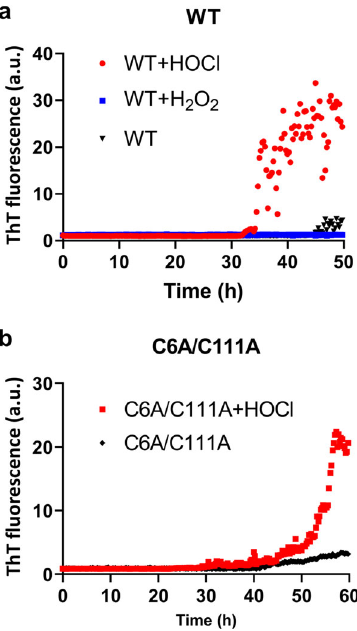
Fig. 6 Promotion of SOD1 fi lament formation by HOCl. The ThT fl uorescence intensities represent the fi lament formation of the wild-type SOD1 protein ( a ) or the C6A/C111A mutant SOD1 protein ( b ). Each protein was treated with HOCl (red), H 2 O 2 (blue), or none (black). The data points are shown as the mean of three independent experiments. The individual raw datasets are presented in Supplementary Fig.